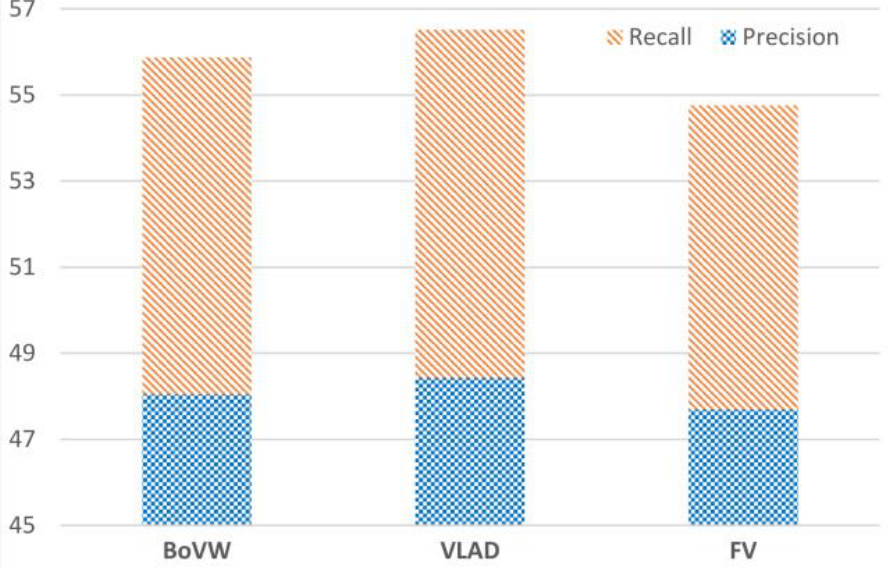
Figure 4. Precision and recall yielded using the three aggregation methods: BoVF, VLAD, and FV.